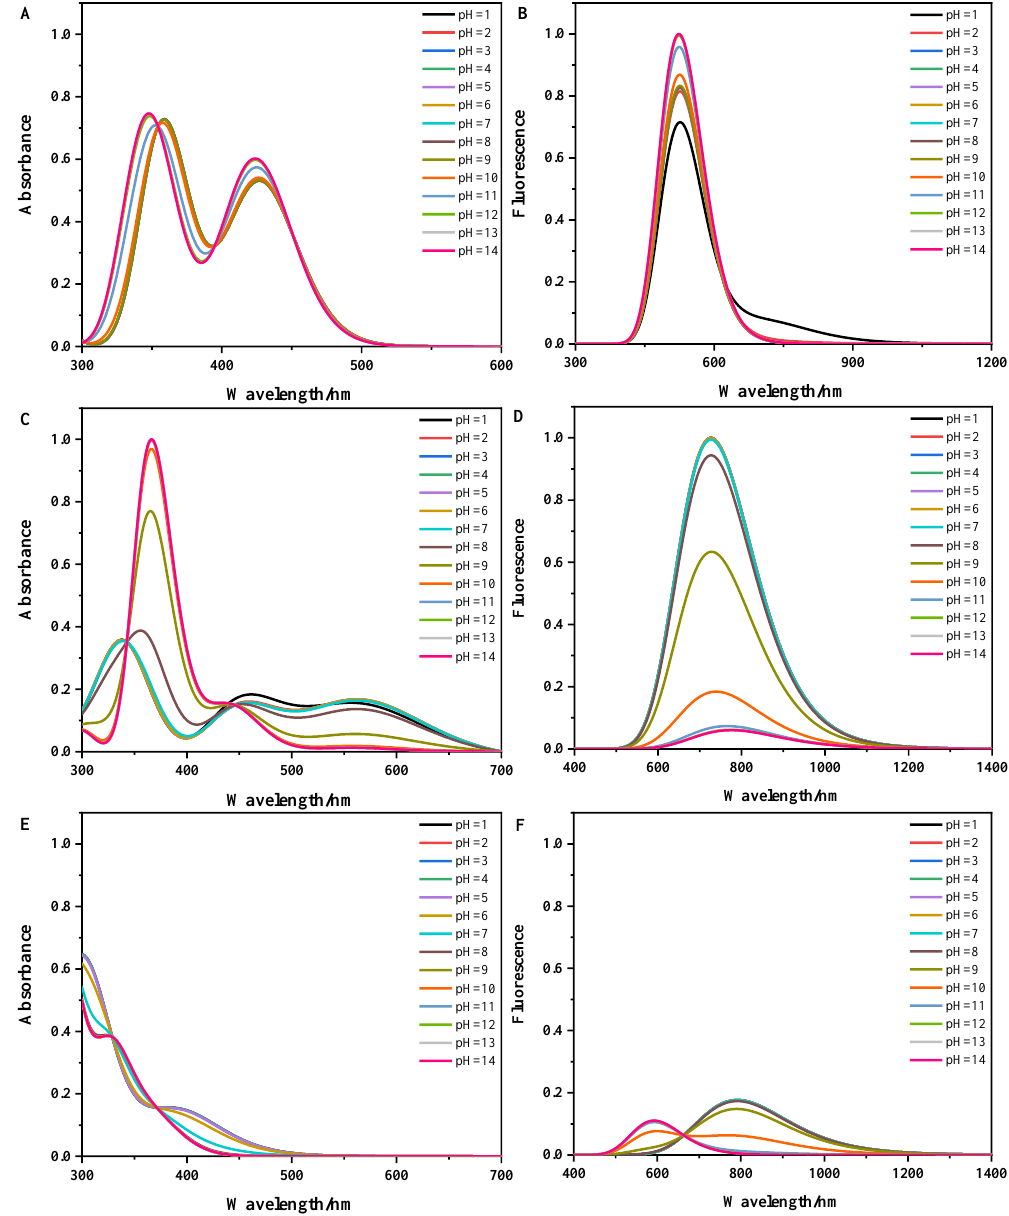
Figure 5. The pH-dependent absorption ( A , C , E ) and fluorescence ( B , D , F ) spectra of flavins.